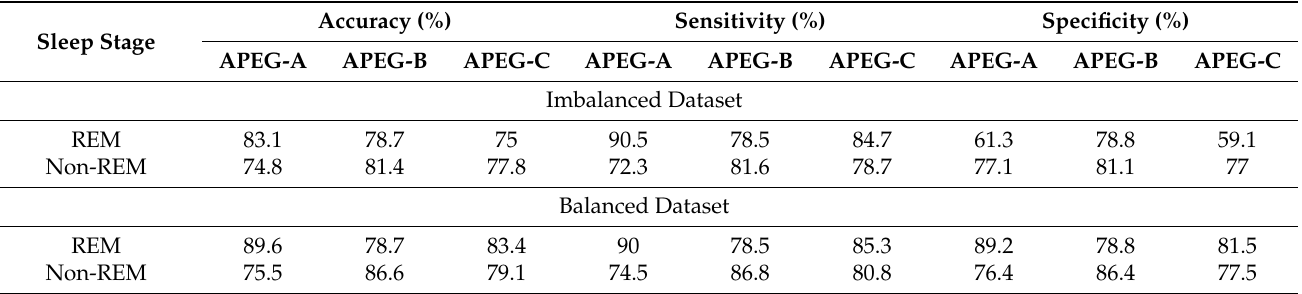
Table 7. The REM and Non-REM classification performance using a PAED 60 s time window based on 8~50 Hz frequency range and SVM classifier.